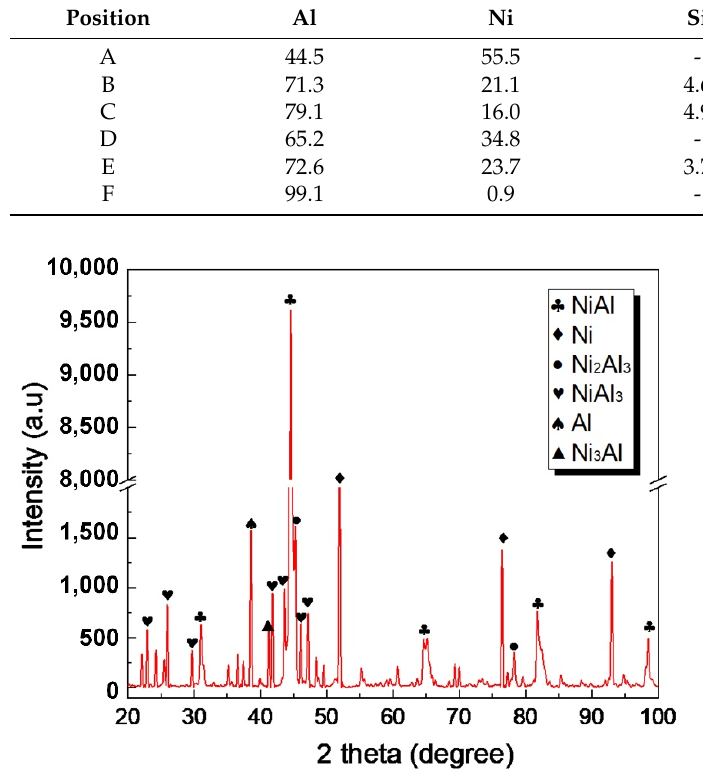
Figure 8. XRD results of Al/Ni interlayer products.